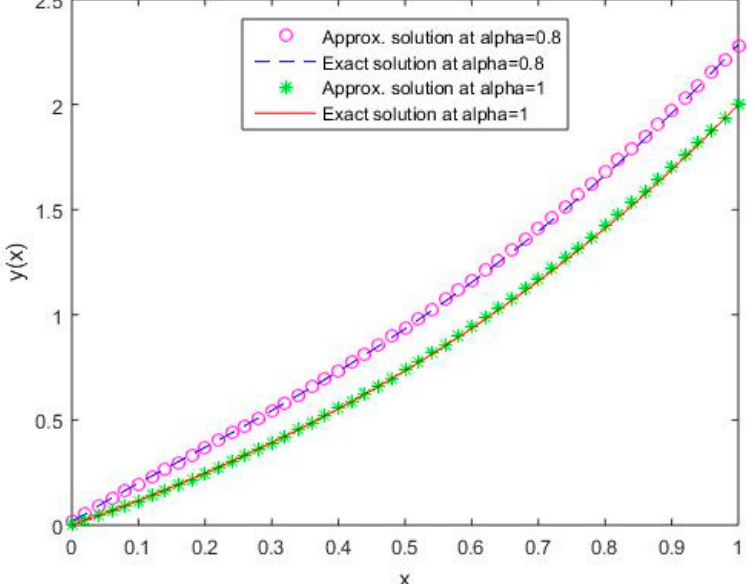
= 0.8 and α = 1, Example